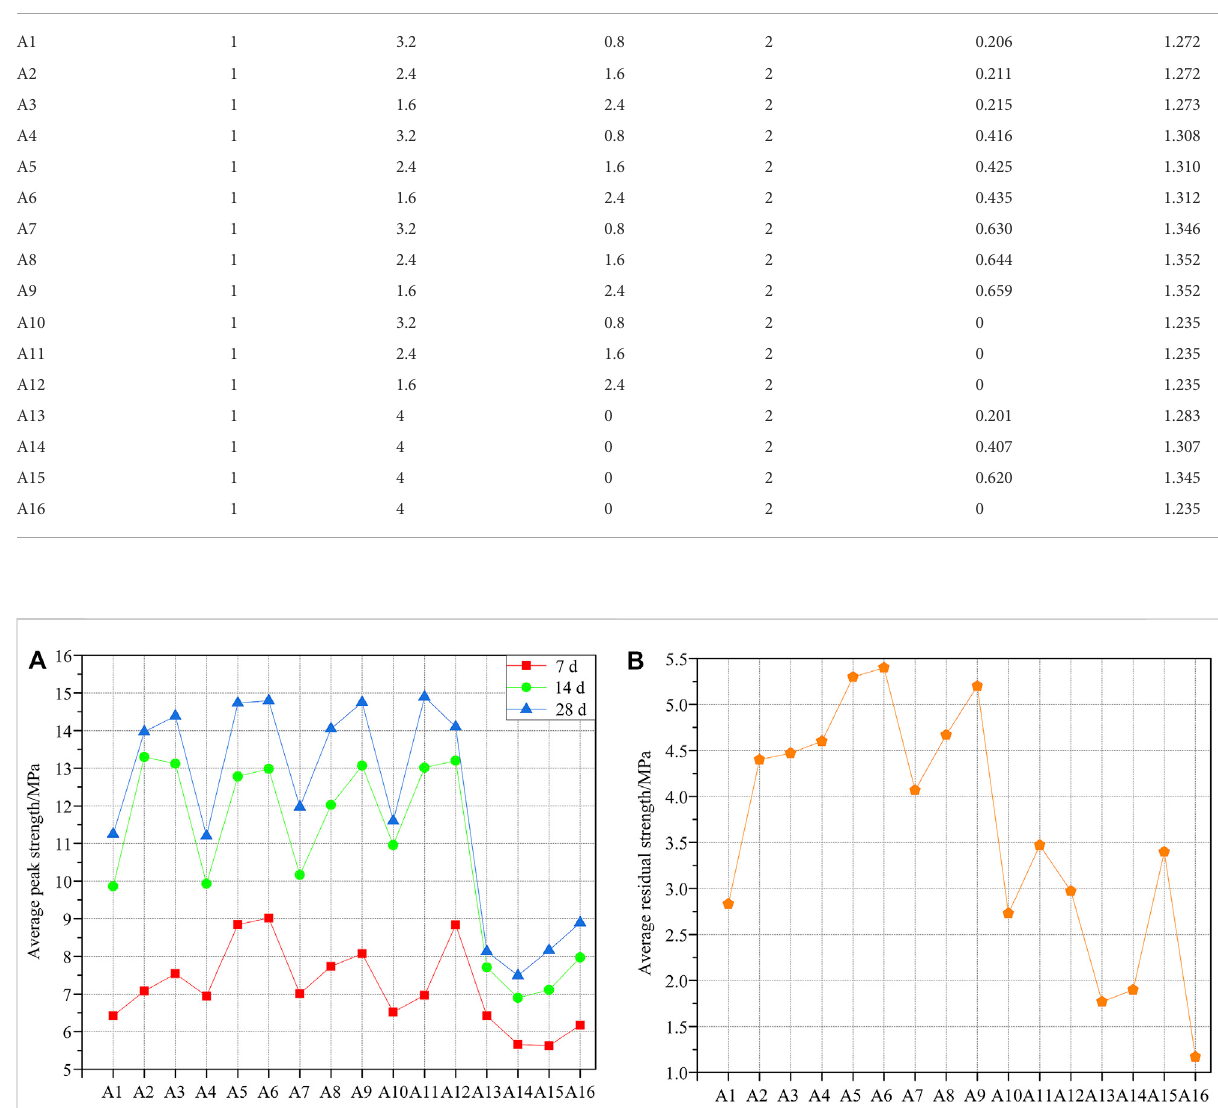
FIGURE 3 Results of the UCS tests. (A) Average peak strength at each measurement time (days 7, 14, and 28); (B) uniaxial compressive residual strength at day